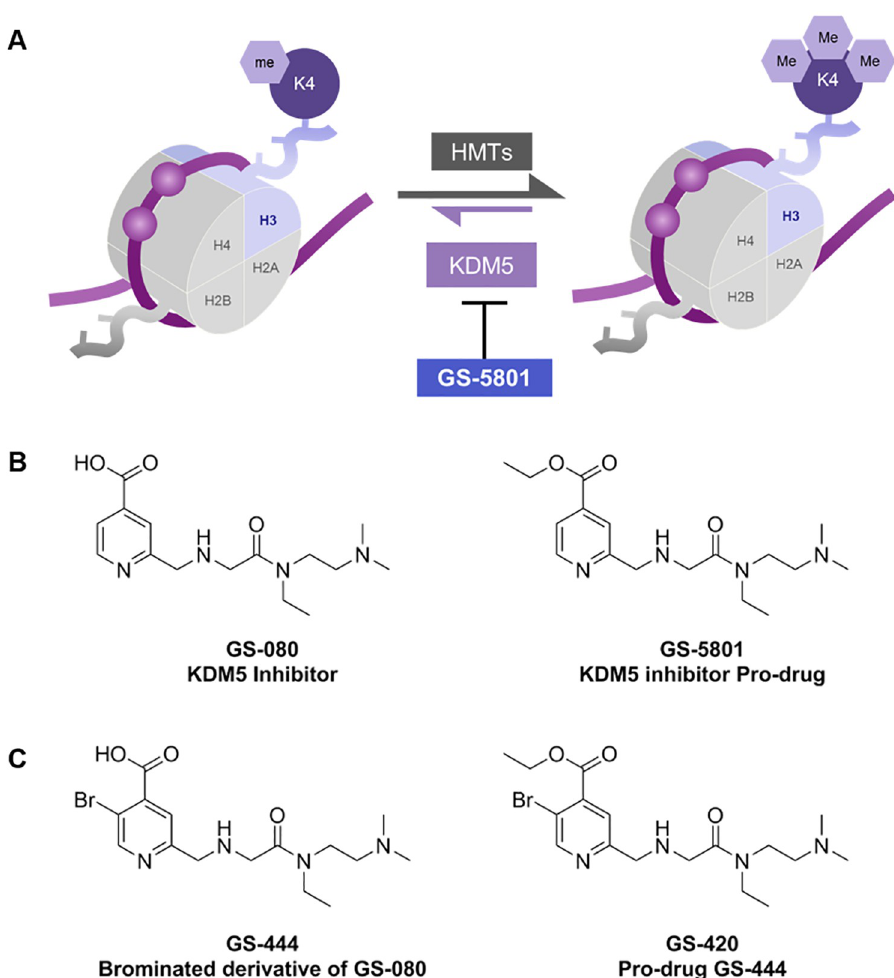
Fig 1. GS-5801 is a prodrug of KDM5 inhibitor GS-080. (A) KDM5 demethylates the lysine 4 of the histone 3 (H3K4) subunit of nucleosomes. Inhibition of KDM5 activity by compounds such as GS-5801 results in accumulation of methylated H3K4 on chromatin through the activity of cellular histone methyltransferases (HMT) that catalyze the mono-, di-, and tri- methylation of H3K4. Chemical structures of prodrug GS-5801 and parent GS-080 (B) as well as prodrug GS-420 and parent GS-444 (C) are